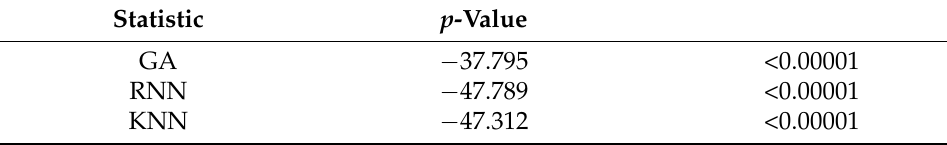
Table 8. Diebold-Mariano test.